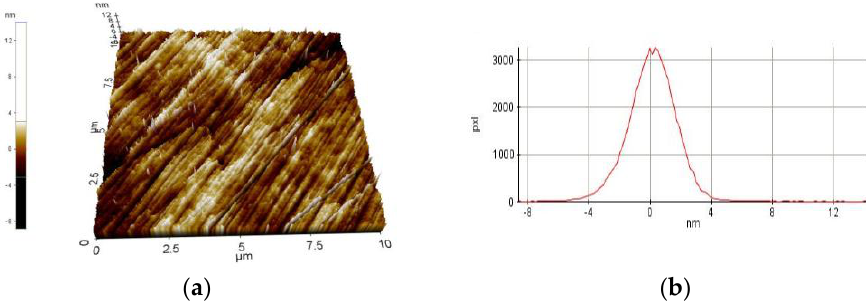
Figure 4. AFM surface topography of AlCrN + CrCN coating: ( a ) 2D image; ( b ) 3D image; ( c ) region histogram.